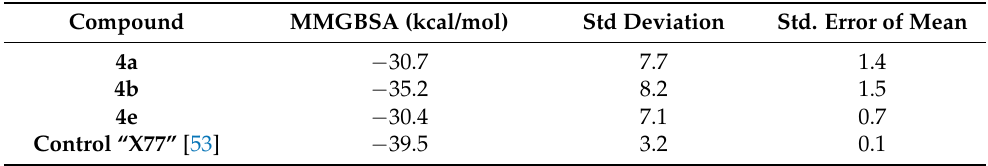
Table 2. List of MM-GBSA binding free energies (in kcal/mol) for compounds 4a , 4b and 4e bound to SARS-CoV-2 main